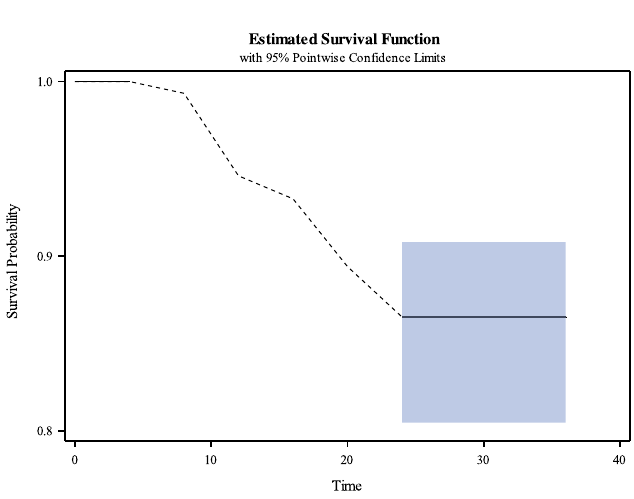
Fig. 3. Estimated MRONJ-free survival. Times in